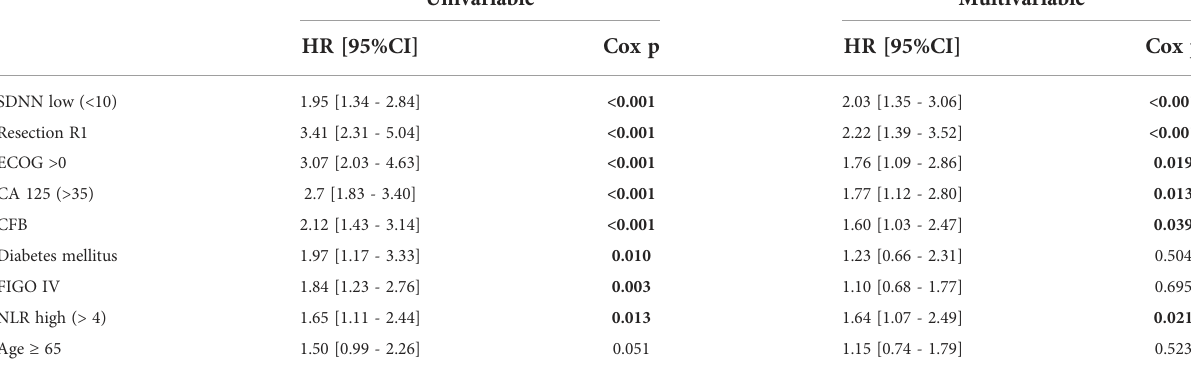
TABLE 3 Univariable and multivariable Cox analysis of overall